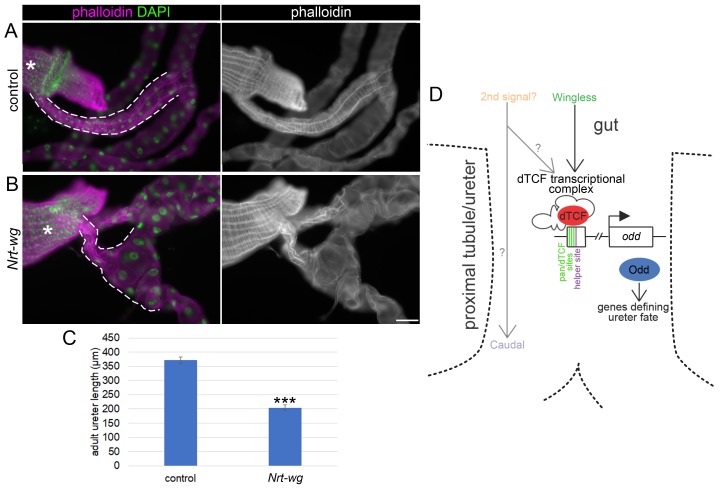
Disruption of the Wingless pathway leads to abnormal morphology of the adult ureters.Single focal plane epifluorescence images of dissected guts and Malpighian tubules of adult flies, stained to show actin (phalloidin) and nuclei (DAPI). White dashed line indicates most proximal tubule/ureter and asterisks indicate midgut. (A) Centred on ureter from sibling control (Nrt-wg/+) adult. (B) Centred on ureter from fly which is homozygous mutant for wg, and expressing membrane-tethered Nrt-wg. Scale bar = 50 μm. (C) Graph showing mean length of adult ureters in control (Nrt-wg/+) and Nrt-wg flies. Error bars indicate SEM. Control n = 47, Nrt-wg n = 30. P (Mann-Whitney) <0.00001***. (D) Model of signals from the gut patterning the proximal Malpighian tubule, necessary for correct ureter development. Enhancer region upstream of odd coding region as in Figure 3B.10.7554/eLife.35373.014Figure 5—source data 1.Quantifications of adult tubule ureter length in Nrt-wg flies.